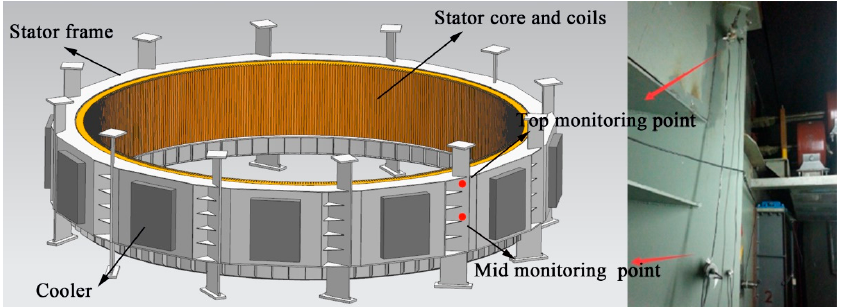
Figure 3. Diagram of monitoring point.